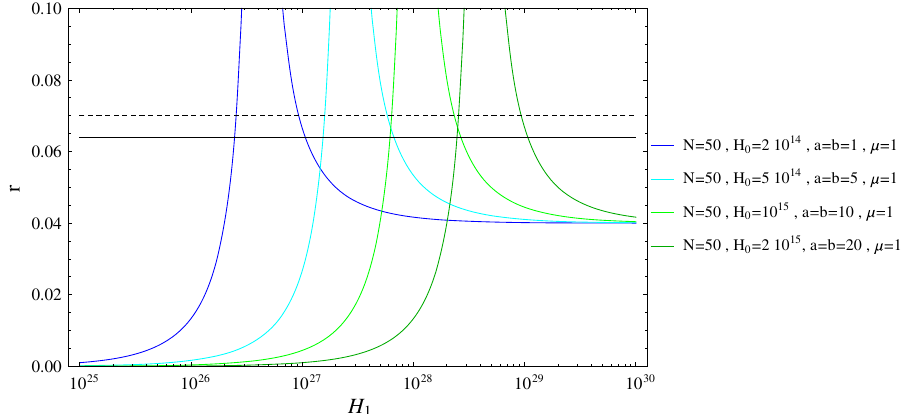
Fig. 6 The tensor-to-scalar ratio with respect to H 1 in for N = 50 and γ = b = 1 and μ = 1s − 1 . The plots are identical for N = 60 and any other values of γ , b and μ . The blue, cyan, green and darker green curves correspond to different values of H 1 and H 0 , respectively. The